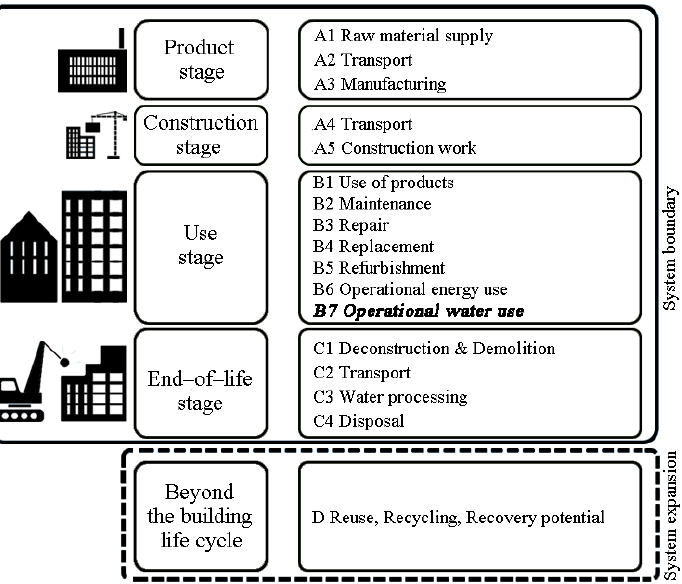
Figure 9. Assessment system boundary based on EN 15978. (The bold and italics stage was not included in this analysis.)